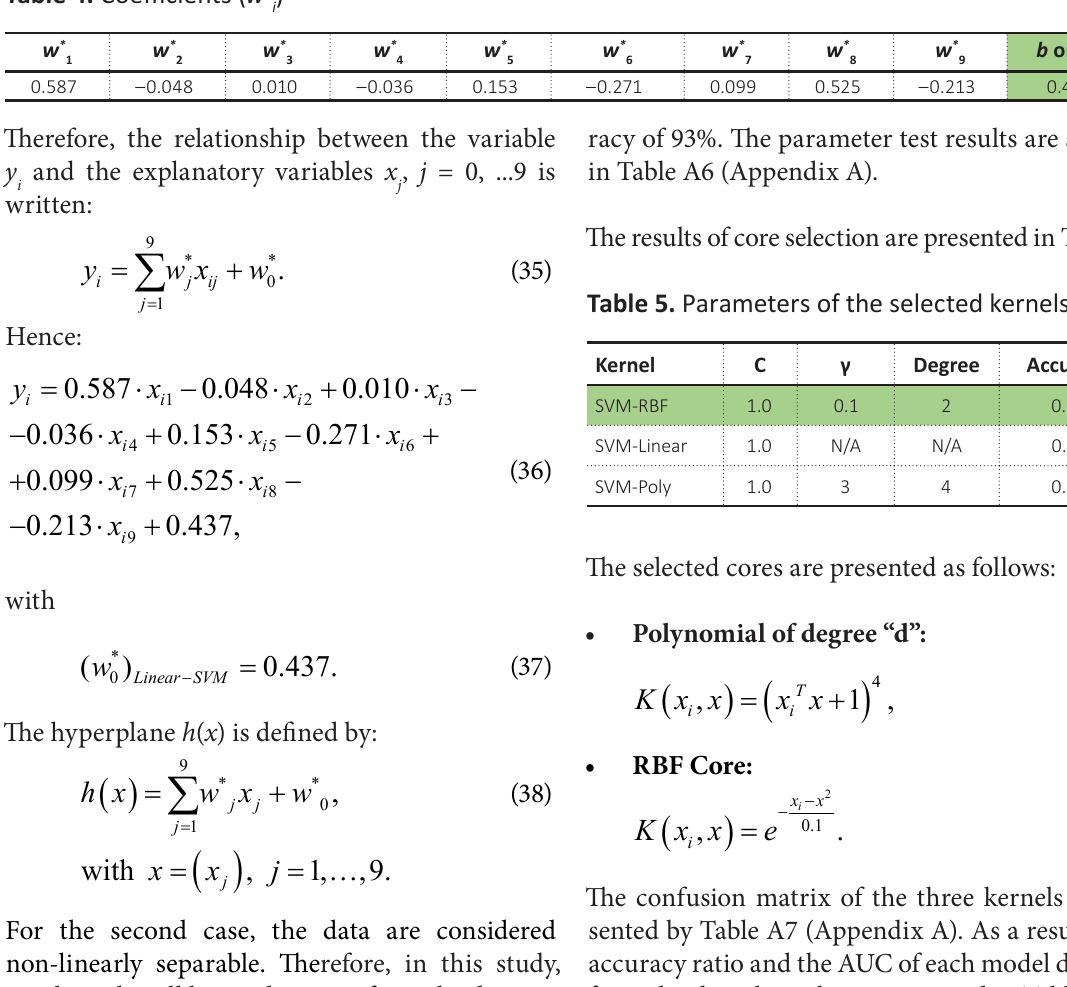
Table 4. Coefficients ( w *